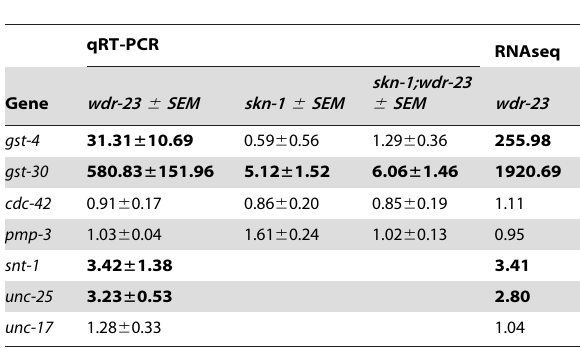
Table 2. qRT–PCR validation of RNA–seq.